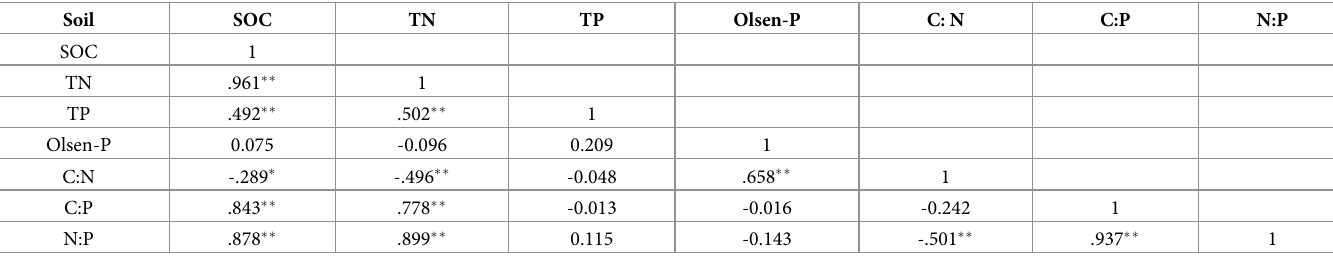
Table 4. Pearson correlation analysis between C, N, and P contents and stoichiometric ratios of karst rocky desert soil. Soil